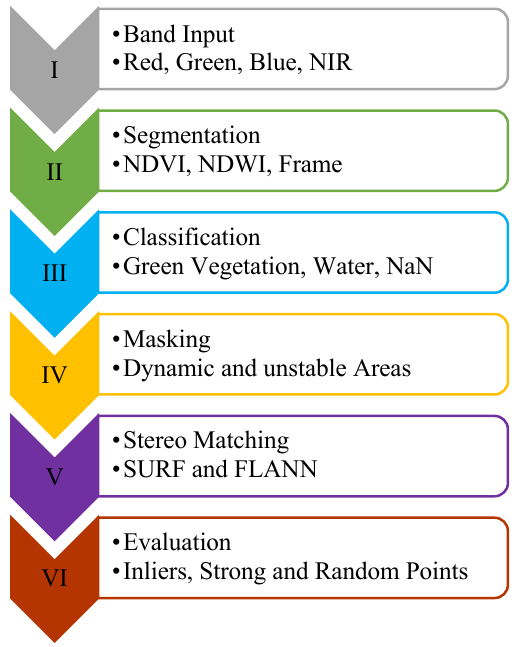
Figure 3. Workflow segmentation driven stereo matching.